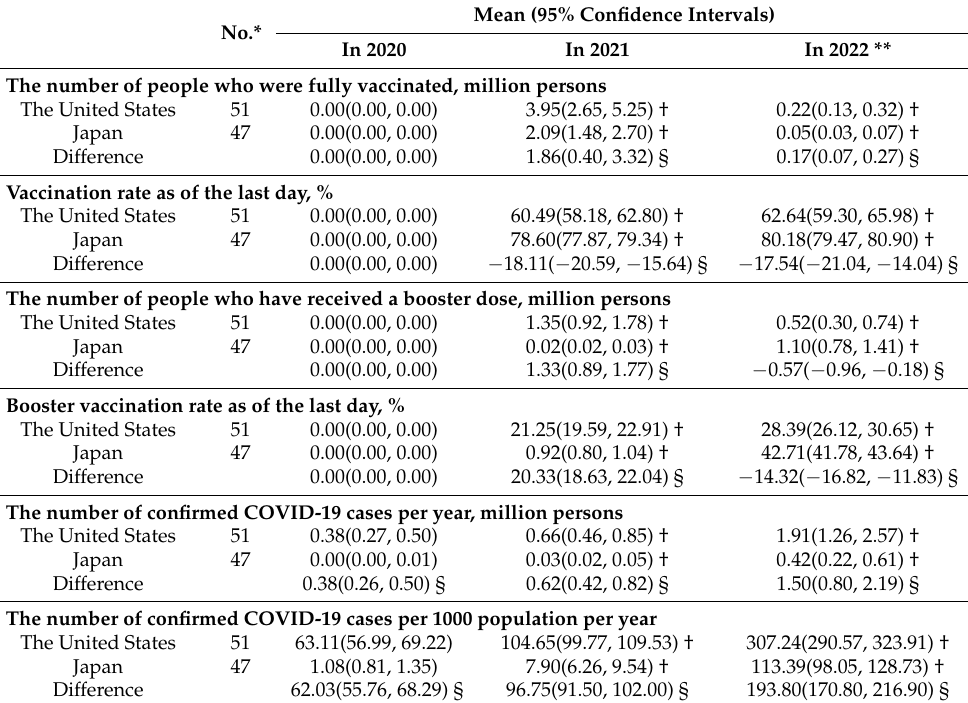
Table 1. The number of vaccinated people and confirmed COVID-19 cases based on the jurisdictions in the United States and Japan.